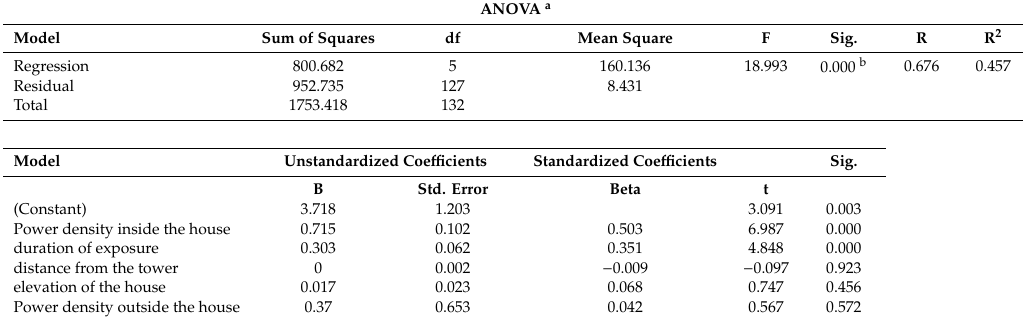
Table 5. Regression analysis with dependent variable GST activity and the five factors, that is, power density outside the house, power density inside the house, duration of exposure, the elevation of the house, distance from the tower as independent variables. a Dependent variable: GST activity.